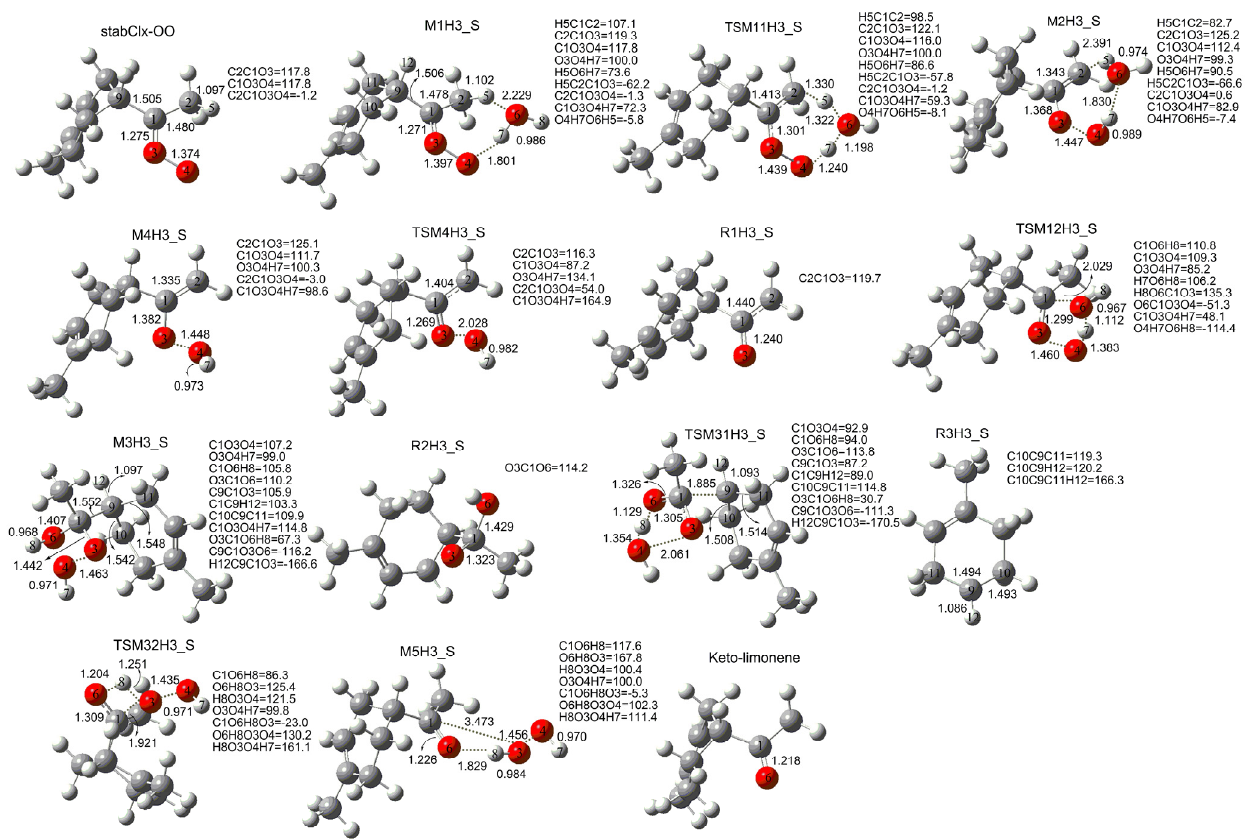
Figure 3. Geometries of the stationary points in the stabCIx-OO + H at the B3LYP/6-31G(d,p) level of theory. Bond lengths and intermolecular distances are given in